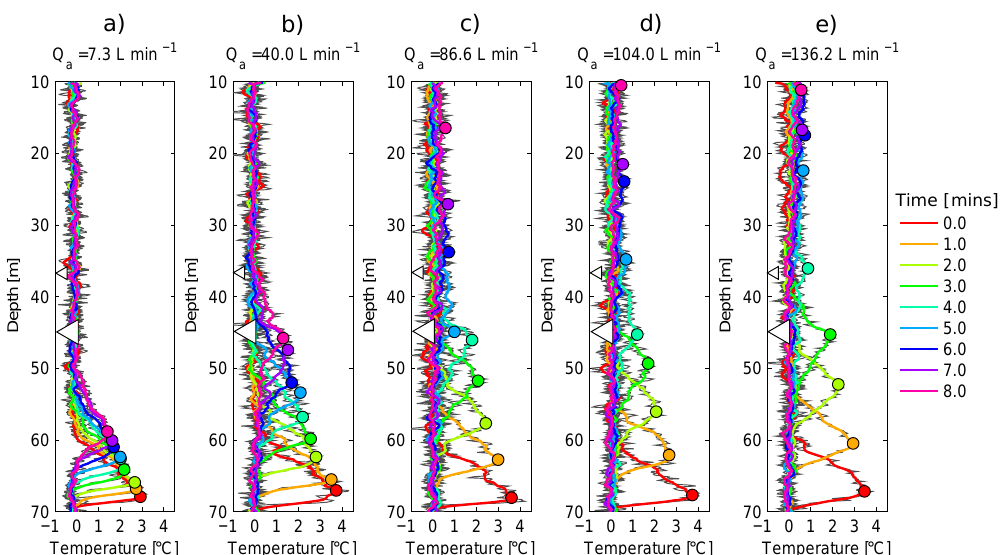
Figure 3. Temperature–depth profiles after pumping begins for the T-POT tests at abstraction rates of (a) 7.3, (b) 40.0, (c) 86.6, (d) 104.0, and (e) 136.2Lmin − 1 . The coloured profiles are 15s time-averaged data that have then been spatially smoothed with a nine-point moving window. Filled circles identify the locations of the plume peaks.